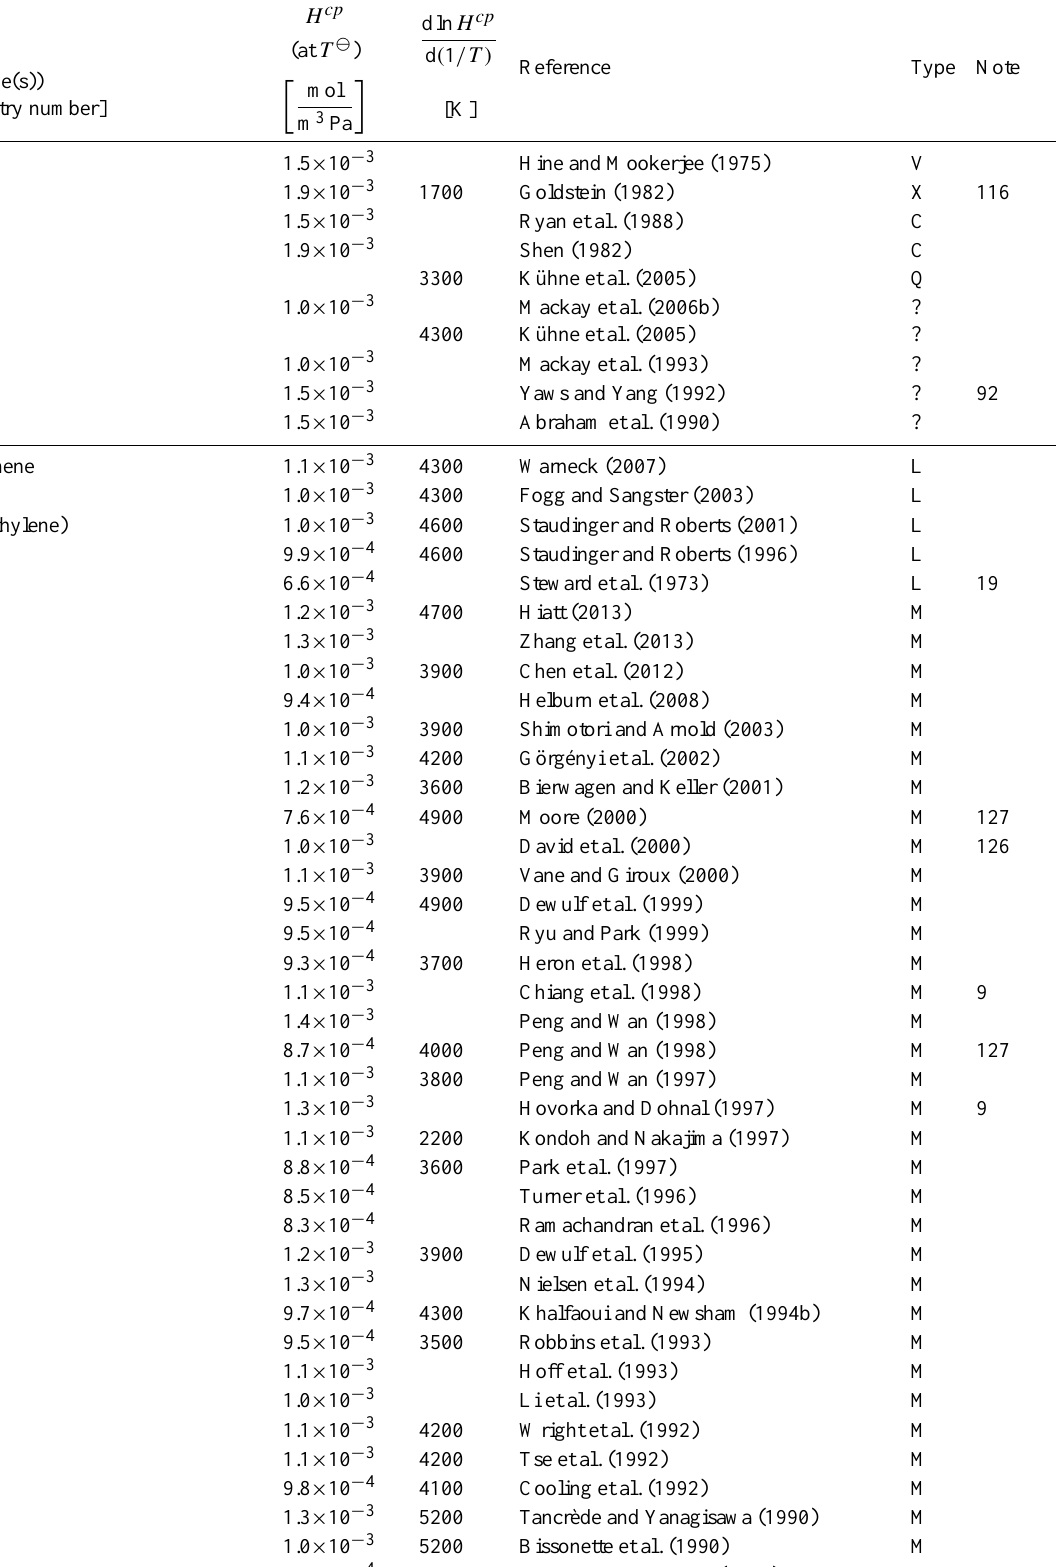
Table 6: Henry’s law constants for water as solvent